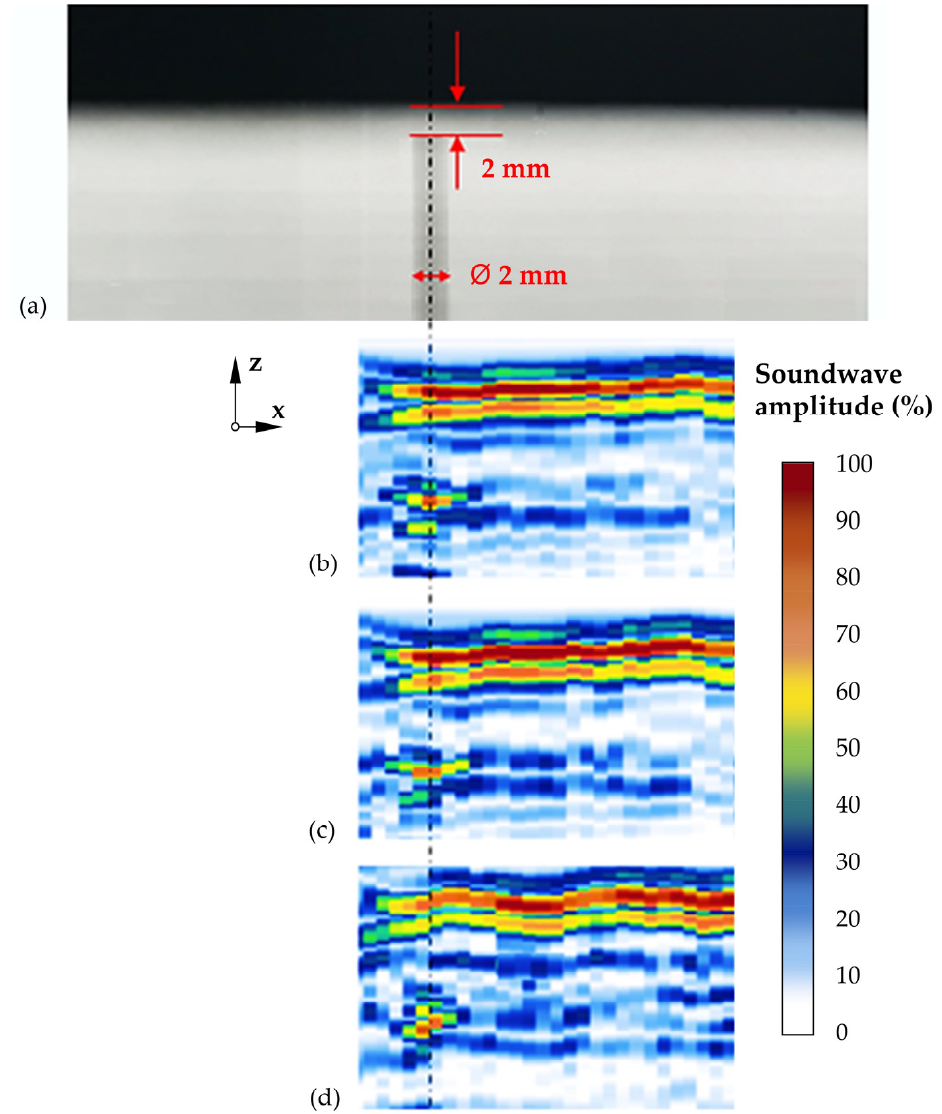
Figure 9. Detection of Ø 2 mm defects at 2 mm depth on deposited ER5356 aluminum walls using ( a ) digital radiography (DR) at room temperature, ( b ) ultrasonic testing (UT) by immersion in a water-filled tank, ( c ) the proposed UT technique at room temperature and ( d ) the proposed UT technique at 100 °C.